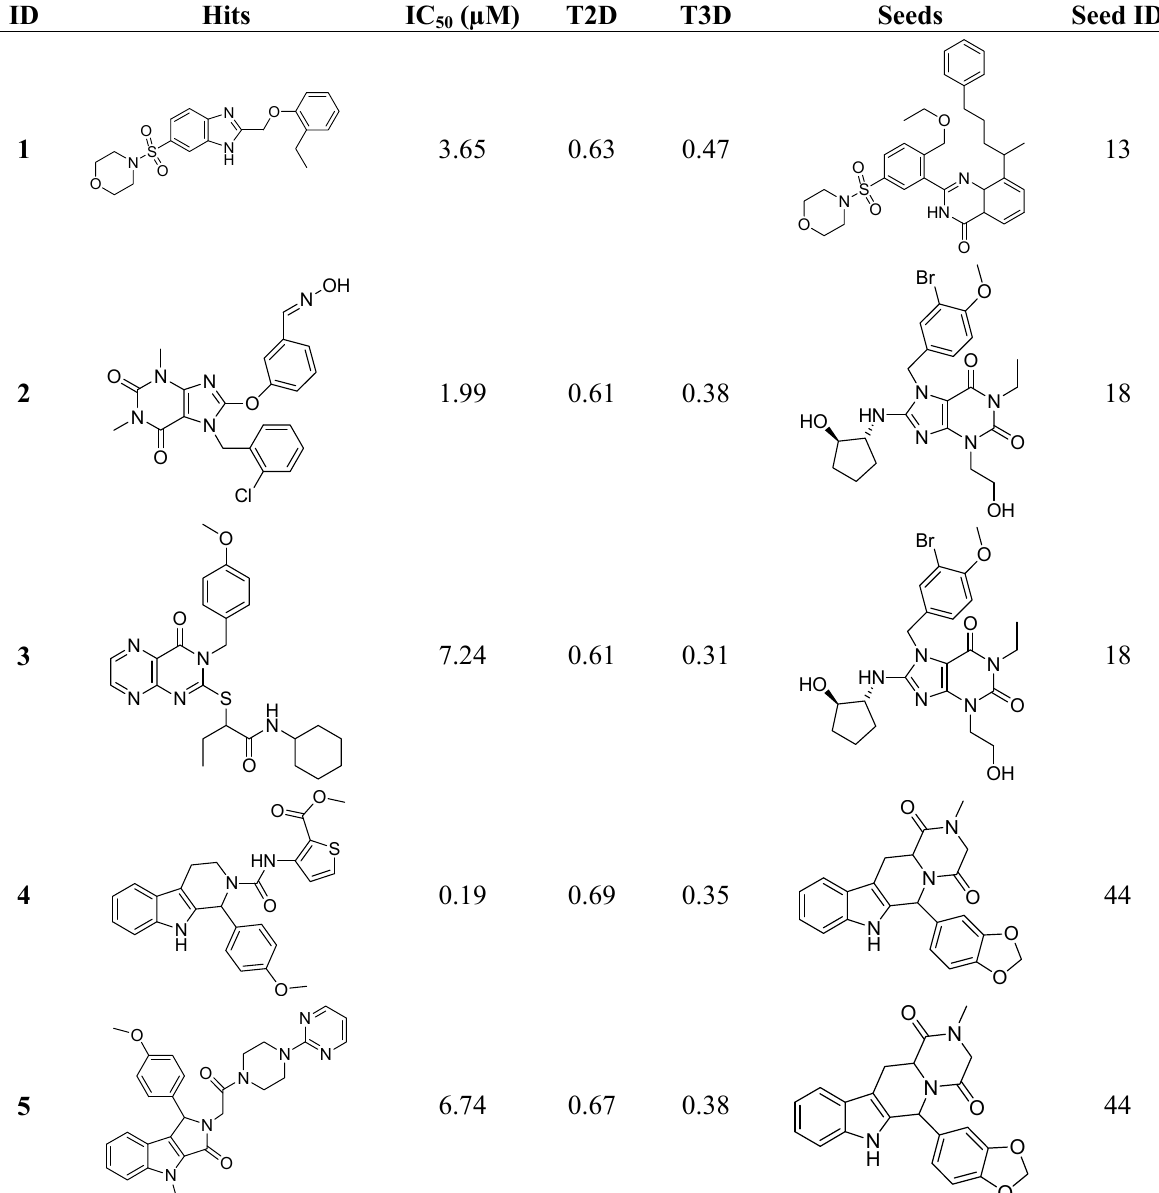
Table 1. First round screening hits as potential PDE5 inhibitors with T2D and T3D values.